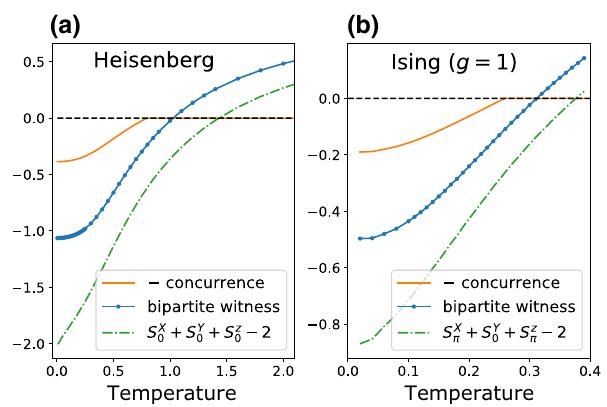
FIG. 4. Entanglement in (a) the Heisenberg chain [Eq. (18)] and (b) the quantum Ising chain at g = 1 [Eq. (19)], for N = 64 spins. The bipartition is of the form A | B | A | B | A | B . . . . Solid orange line: (minus) the concurrence [42] between nearest neigh- bors. Blue dots: bipartite witness 1 + ( 2 W / N ) with W given in Eq. (24). Dashed-dotted green line: multipartite witness S X + S Z − 2 at the optimal wave vectors k S Y k Y k Z Eq. (17)] (for all witnesses, entanglement is detected for negative